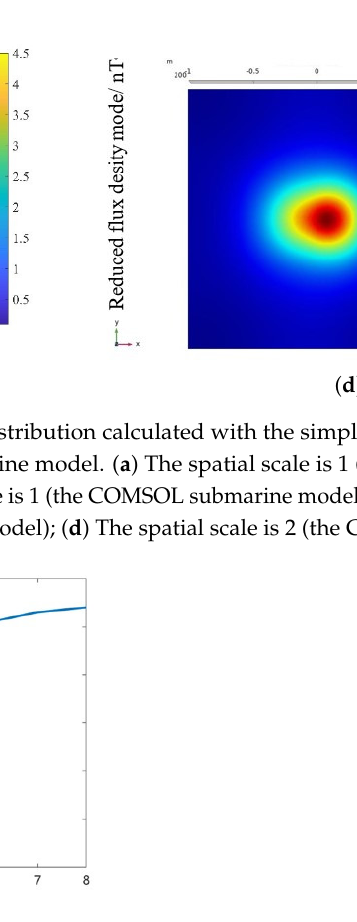
Figure 12. Equivalent consistency of the simplest multiple magnetic dipole model with multiple spatial